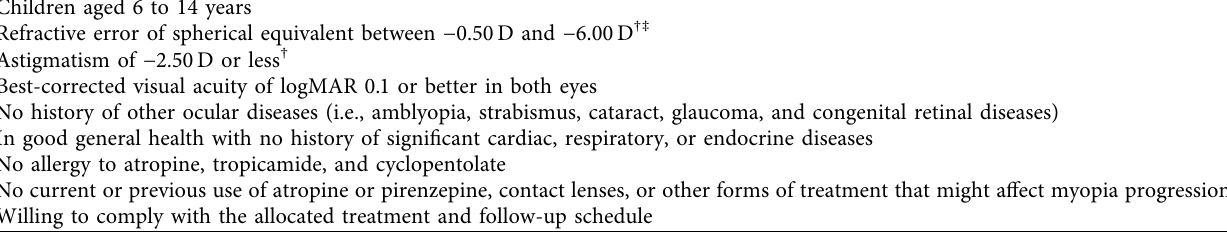
Table 1: Eligibility criteria for the